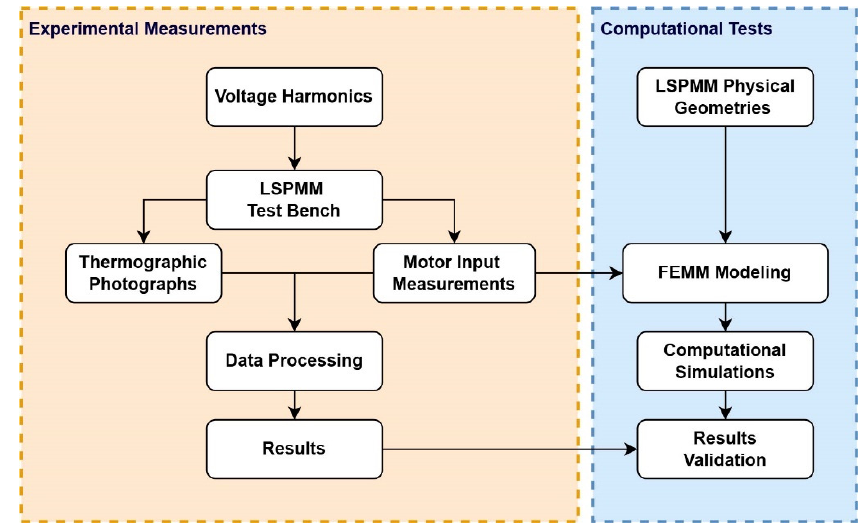
Figure 3. Methodology Flowchart.